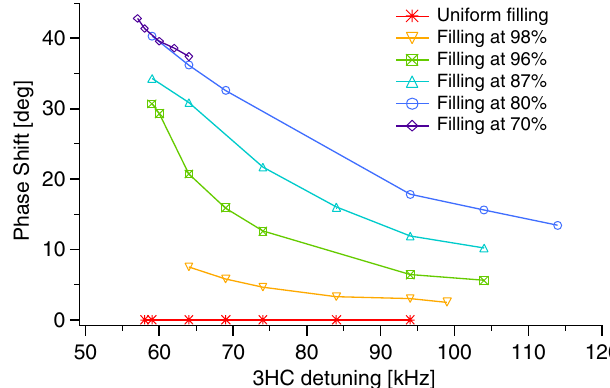
FIG. 5. (Color) Relative stable phase along the bunch train vs the 3HC detuning, for uniform filling; I 2 : 0 GeV .